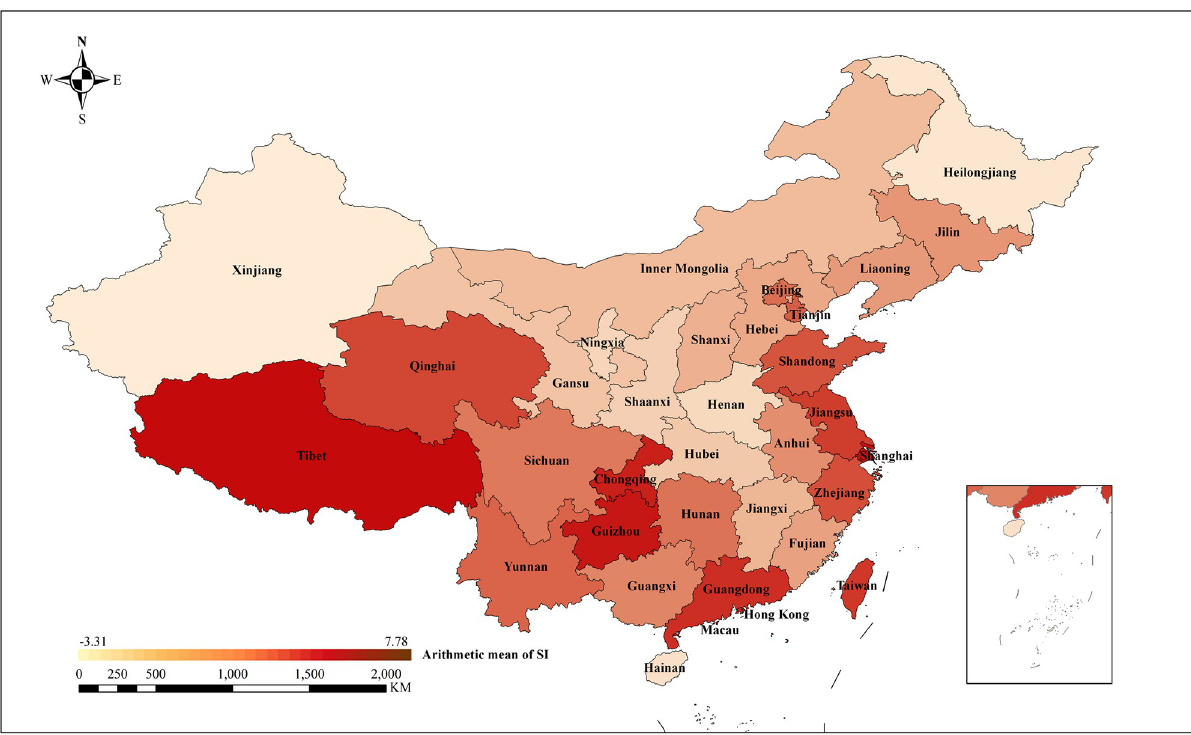
Fig 8. Geographical distribution of the arithmetic average of SI. Shape file source: republished from http://www.gscloud.cn under a CC BY license, with permission from Geospatial Data Cloud, original copyright [2022]; Own Map output: using ArcGIS 10.2 Software analysis.